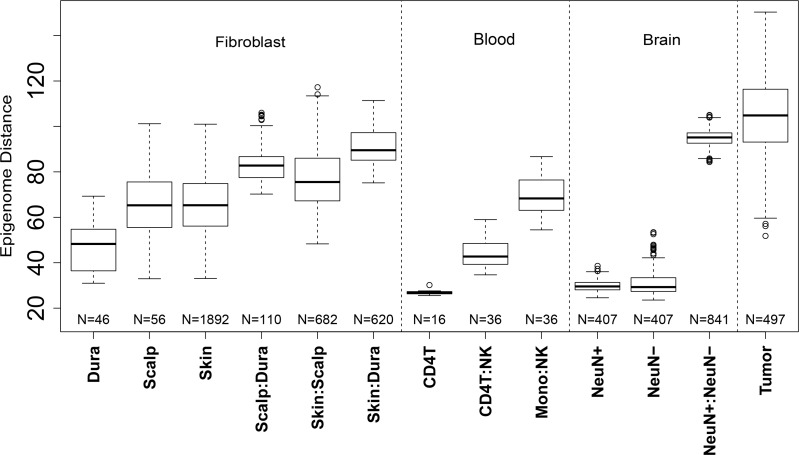
Increased methylome distances within scalp-derived fibroblasts.Y-axis: methylome (Euclidean) distance between pairs of samples stratified by cell and tissue types. CD4T: CD4+ T-cell, NK: natural killer cell, Mono: monocyte, NeuN+: neuronal DLPC cell, NeuN-: non-neuronal DLPFC cell.